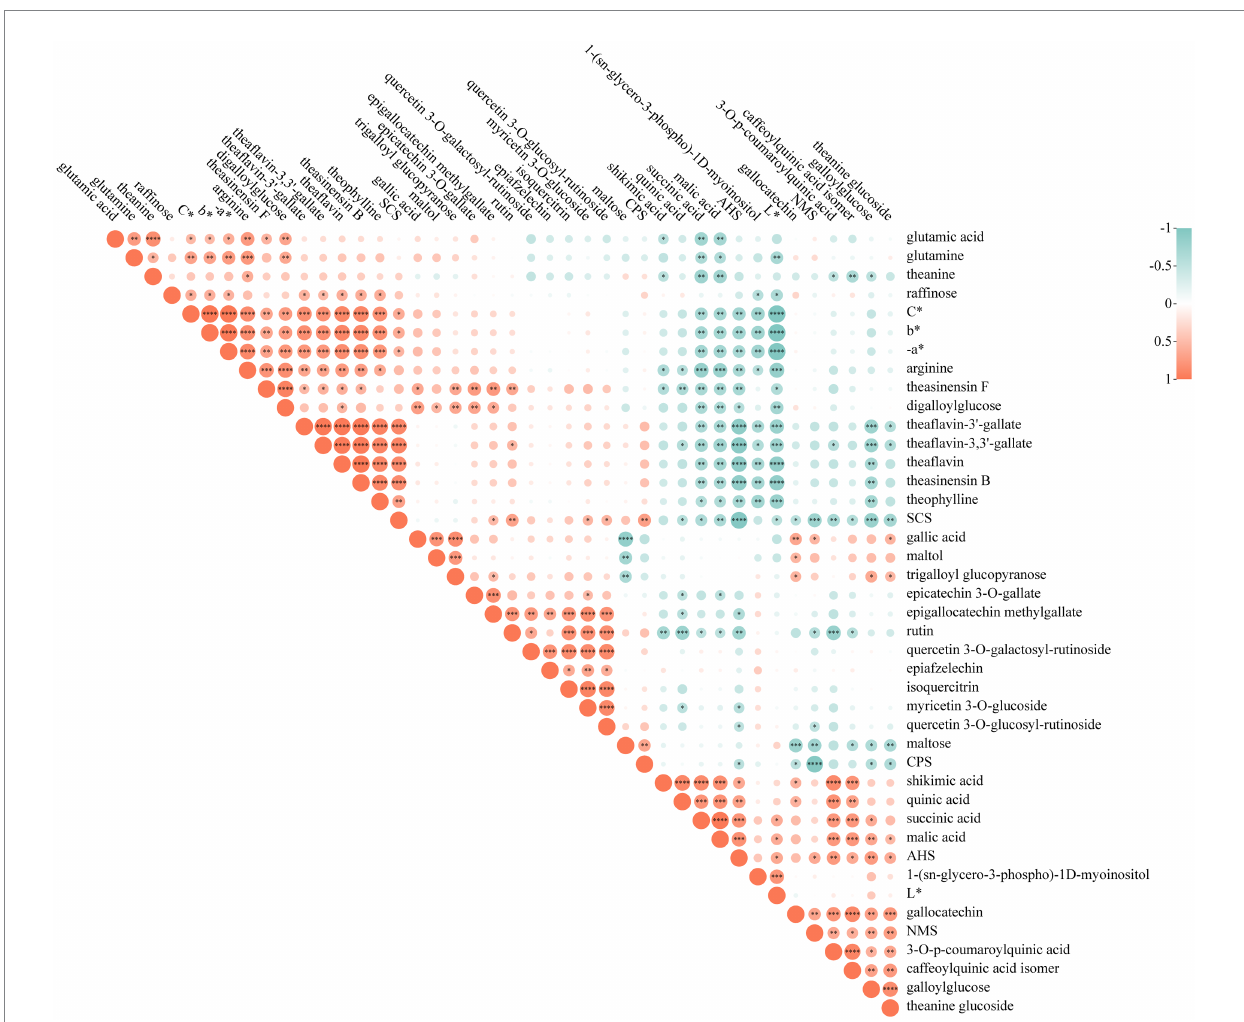
FIGURE 6 Correlation matrix analysis between key differential metabolites ( p < 0.05, VIP > 1) and sensory indicators illustrated as heatmap. The correlation coefficient values were ranged from − 1 (colored in green) to 1 (colored in red). A larger circle means a stronger correlation and a smaller circle means a weaker correlation. Correlation analysis was performed by PearsonDist. * p < 0.05, ** p < 0.01, *** p < 0.001, and **** p <